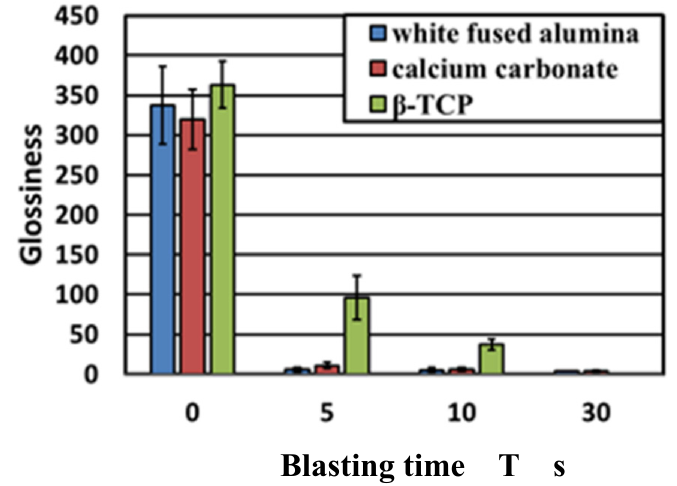
Figure 7. The changes in glossiness are shown. In the blasting of WA particles and CaCO 3 particles, the glossiness shows almost zero. Although β -TCP has a slight decrease in glossiness compared with other particles, it has a significant decrease. Considering that a part of the particles has changed to a satin-finished surface, it affects the aesthetics.